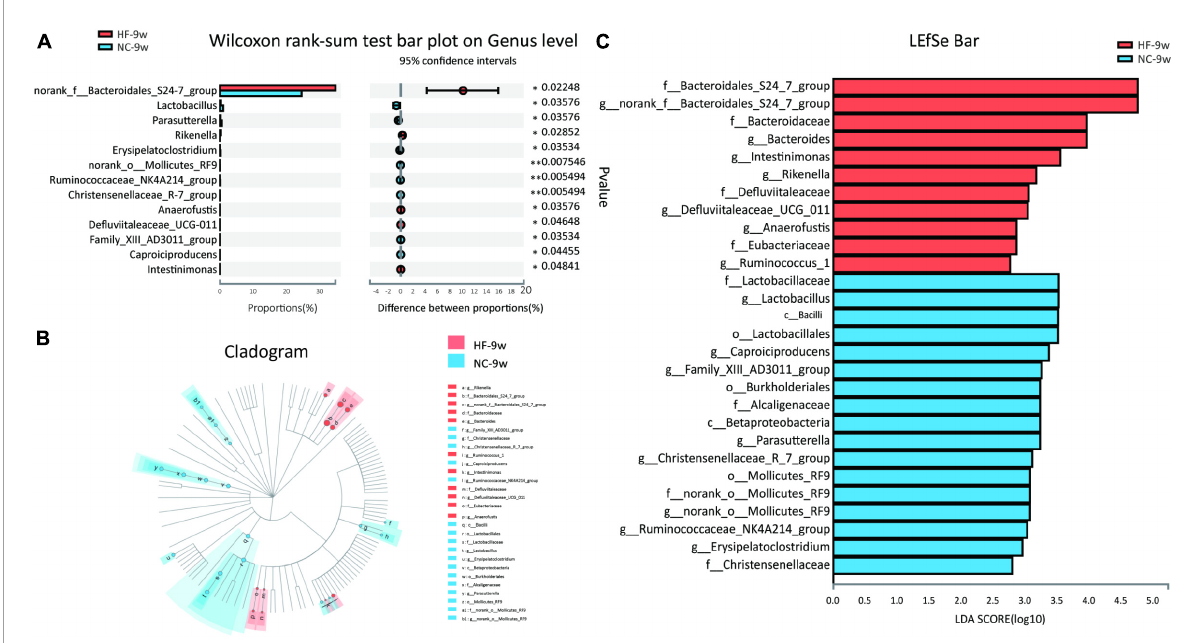
FIGURE8 Dysbiosis of gut microbiota induced by the maternal HF diet was partly recovered in adult offspring. (A) Column chart of species with significant differences at the genus level. (B,C) LEfSe analysis of the gut microbiota from the phylum level to the genus level with LDA values of 2.0 (NC-9w, n = 6; HF-9w, n = 5). * p < 0.05, ** p < 0.01 vs. NC-9w. NC, normal chow diet; HF, high-fat diet. LEfSe, linear discriminant analysis (LDA) effect